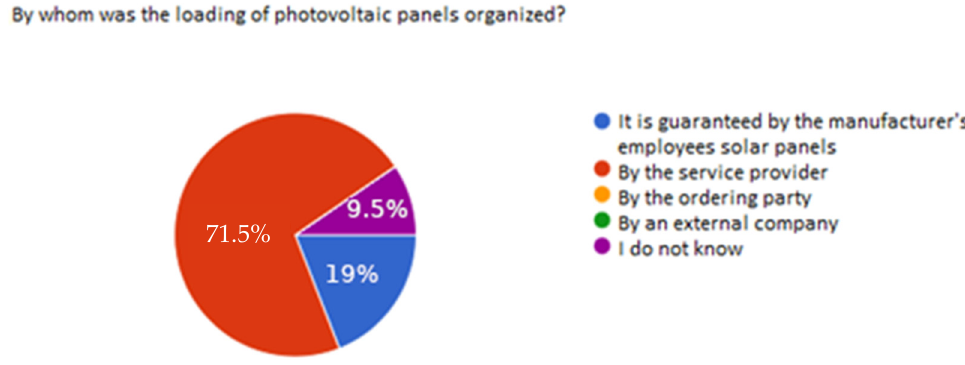
Figure 8. Loading process.